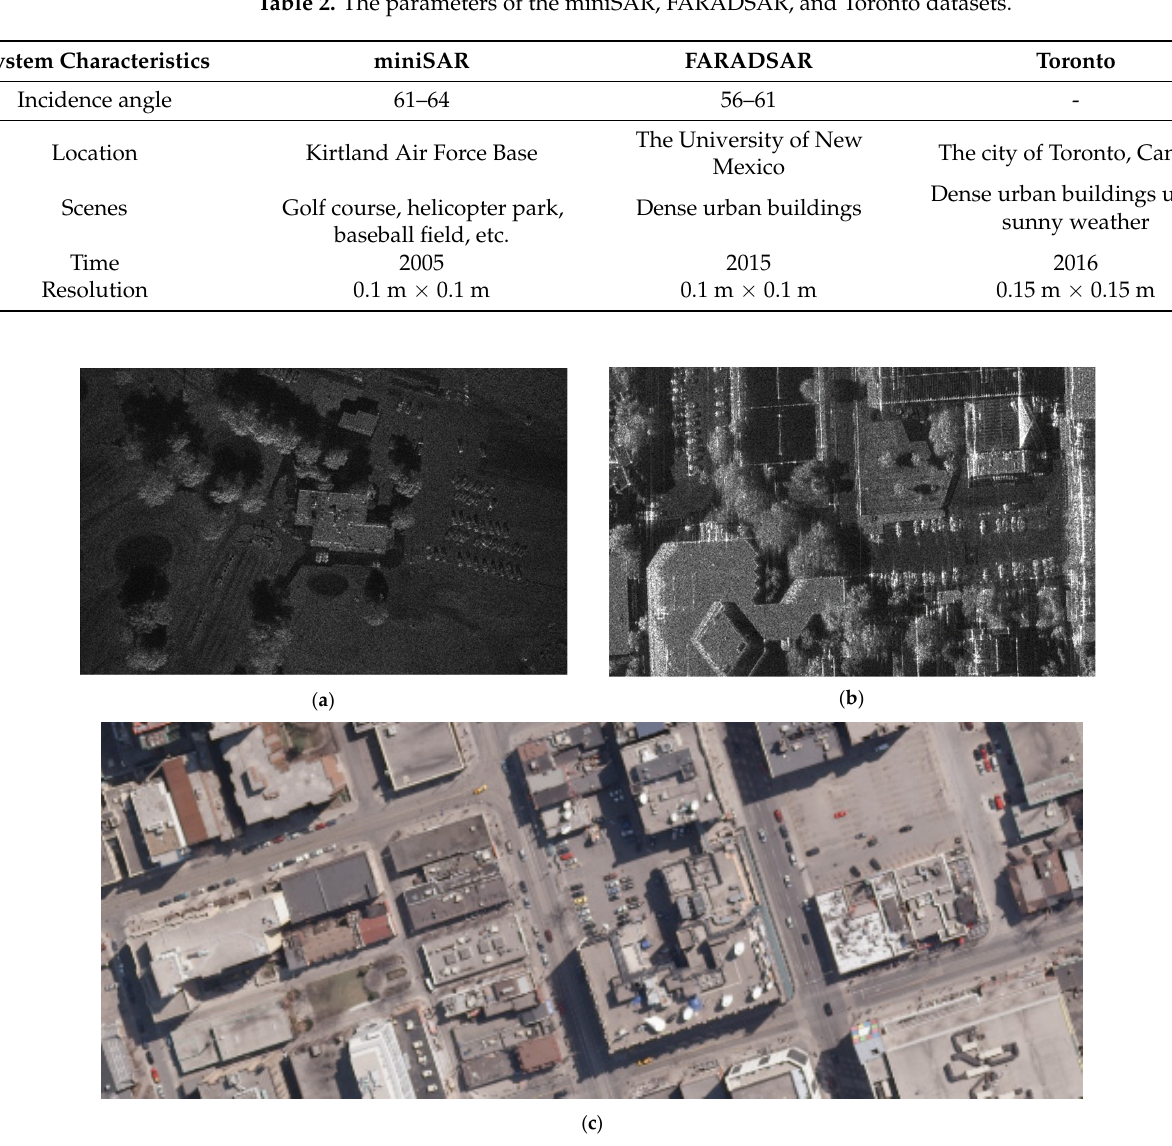
Figure 4. Examples of the miniSAR, FARADSAR, and Toronto datasets. ( a ) An image in the miniSAR dataset; ( b ) an image in the FARADSAR dataset; ( c ) an image in the Toronto